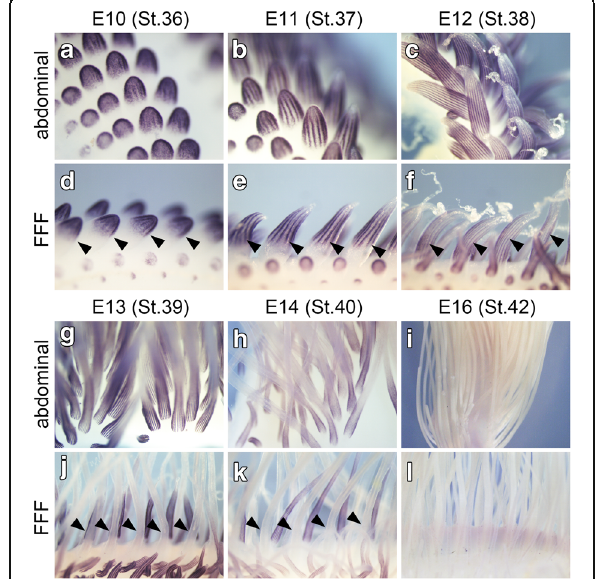
Fig. 3 Whole-mount observations of shh expression in the abdominal and FFF regions. a – c , g – i shh expression in the abdominal tract by whole-mount in situ hybridization from E10 (HHstage 36) to E16 (HHstage 42). d – f , j – l shh expression in the FFF region. Arrowheads in ( d – f ), ( j ), ( k ) indicate feather buds in the FFF region: note that in j and k , feather buds in the FFF region have little shh